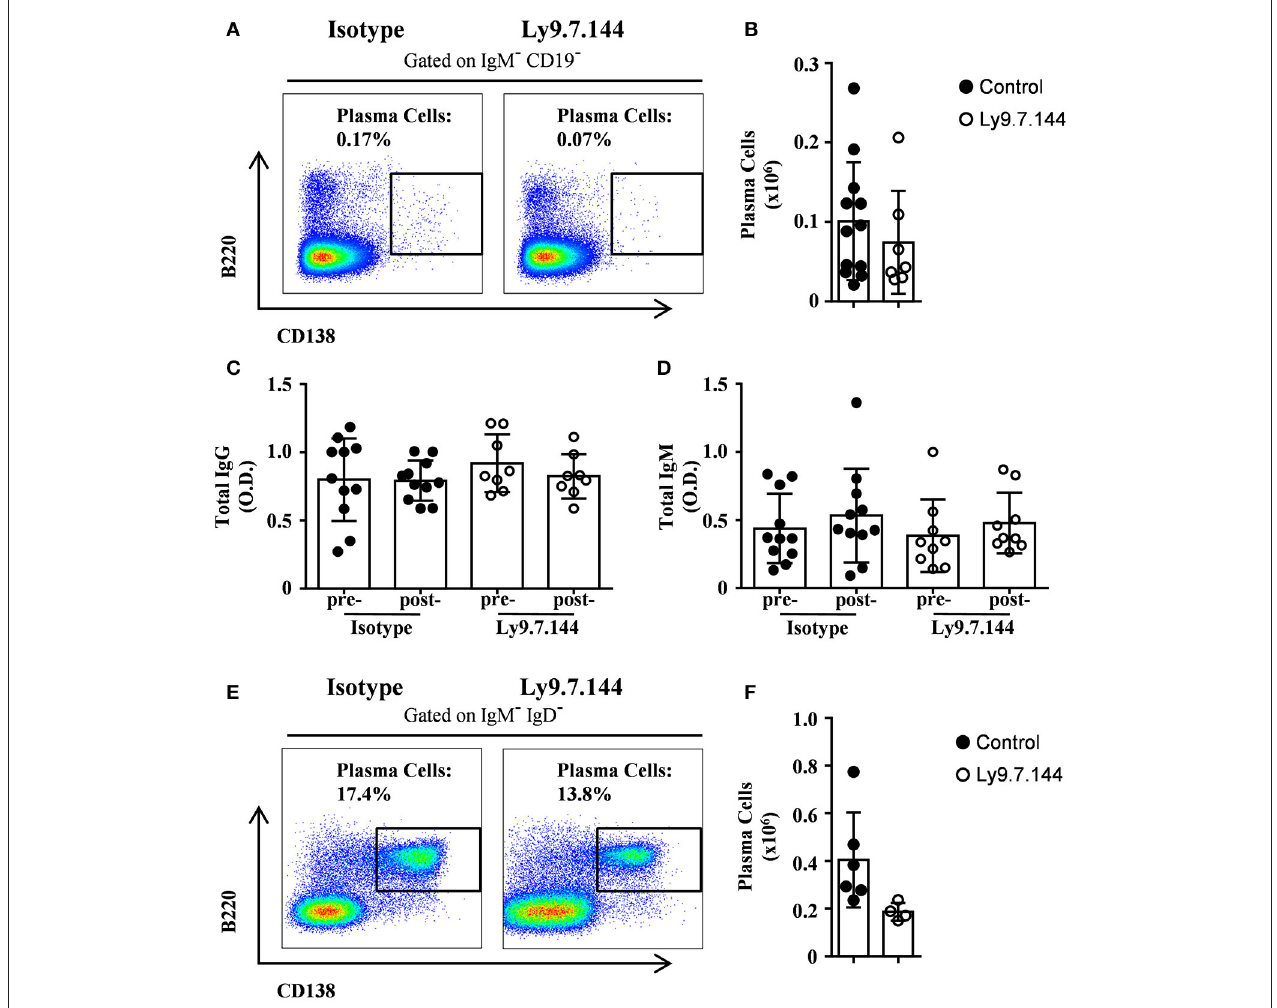
FIGURE 9 | Treatment with anti-Ly9 does not cause general immunosuppression. Representative dot plots of B220 and CD138 are shown for plasma cells from splenocytes gated on CD19 − IgM − (A) or bone marrow cells gated on IgD − IgM − . (E) from 30-weeks-old (A–D) or 14-weeks-old (E,F) female NOD.H-2 h4 mice treated with two doses (A–D) or a single dose (E,F) of Ly9.7.144 (right plots) or isotype control (left plots). Absolute counts for the different plasma cells from spleen (B) and bone marrow (F) are shown. Total levels of IgG (C) or IgM (D) are presented from sera of female NOD.H-2 h4 mice previous to treatment (24-weeks-old) and after treatment (30-weeks-old).Mice treated with Ly9.7.144 mAb are represented as empty dots and mice treated with isotype control are represented as black dots. Results are expressed as mean ± SD. (unpaired two-tailed t -test). Data are pooled from three independent experiments (A–D) or from one experiment (E,F)